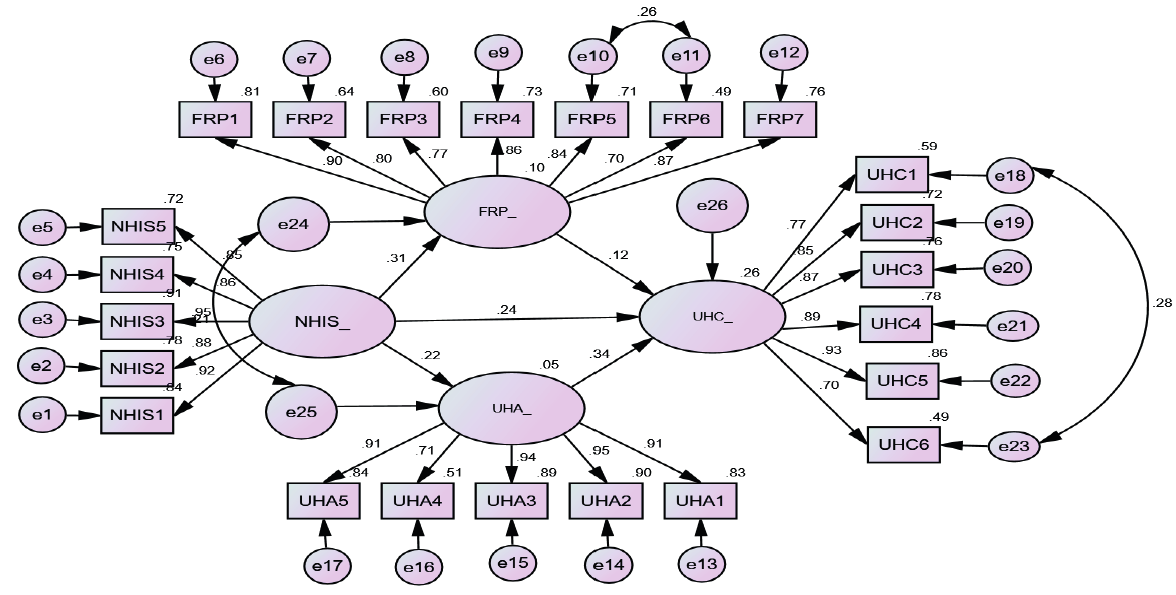
Figure 3. Standardized path of the alternative